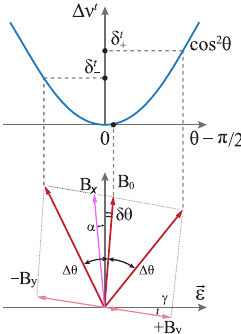
Fig. 6 Sketch of the bias magnetic fi eld direction stabilization. Top: clock 4-3 transition frequency shift as a function of the misalignment angle from θ = π /2. δ t δ t þ ( (cid:2) ) are the clock transition frequency shifts when additional 0 magnetic fi eld + B y ( − B y ) is applied. Bottom: orientation of the bias magnetic fi eld for nominal operation (small deviation δθ from θ 0 = π /2) and for calibration measurements ± Δ θ . Rotation of B 0 is accomplished by applying additional ± B y during the clock interrogation period. The misalignment angle δθ is deduced from the frequency difference δ t ± according to Eq. (18). Angles α and γ depict misalignment of B x (magnetic fi eld produced by main coils) from π /2 and B y from 0,